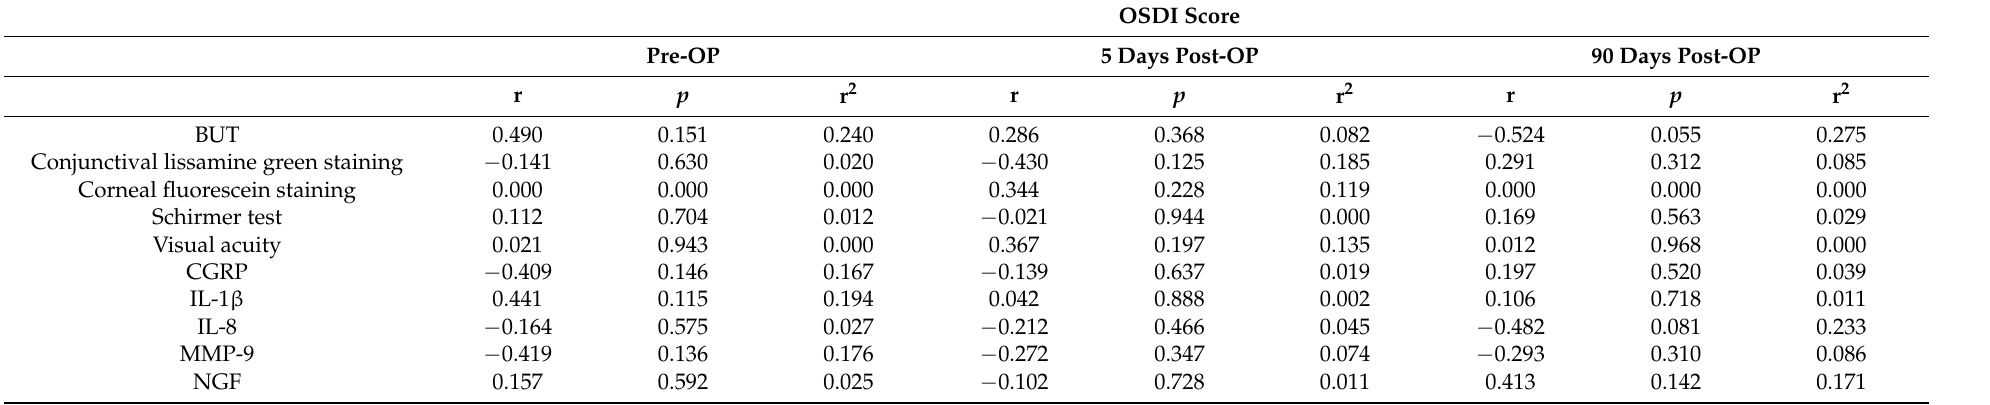
Table 5. Correlation between individual clinical measurements or protein concentration and ocular surface disease index (OSDI) score. Abbreviations: BUT =